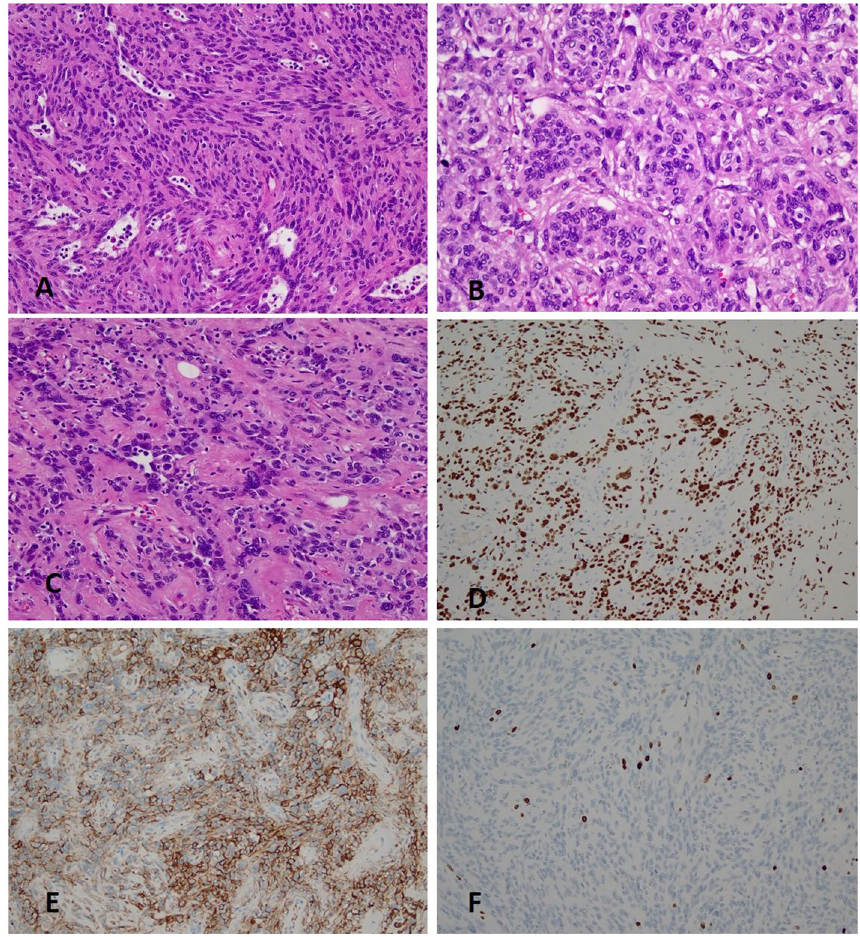
Fig. 2 Solid cellular area of the tumor. A , B The spindle tumor cells are arranged in fascicular and whorled pattern resembling solitary fibrous tumor(H&E stain, 200); ( C ) In some epithelioid areas, atypical or even bizarre nuclei can be seen (H&E stain, × positive for TTF-1 and EMA ( 100). ( F ) The Ki-67 index of the spindle tumor cells is low ( ×